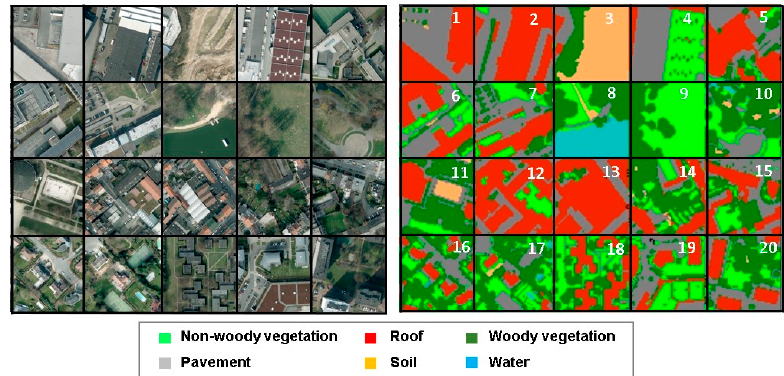
Figure 2. Orthophoto ( left ) and digitized validation data ( right ) of the twenty 100 × 100 m